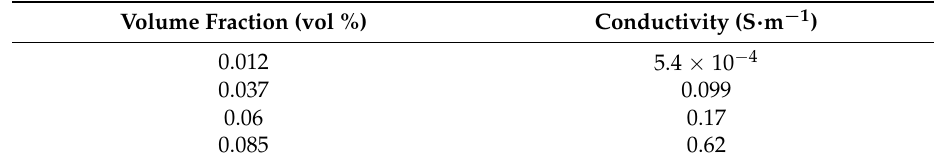
Table 2. The conductivity of modified GE/EP composites with different volume fractions of modified GE according to the conversion of the mass.